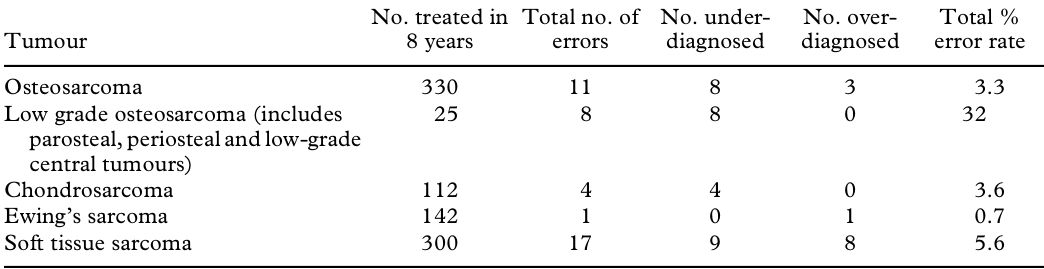
Table 1. Error rates for the most common tumours over the 8-year period